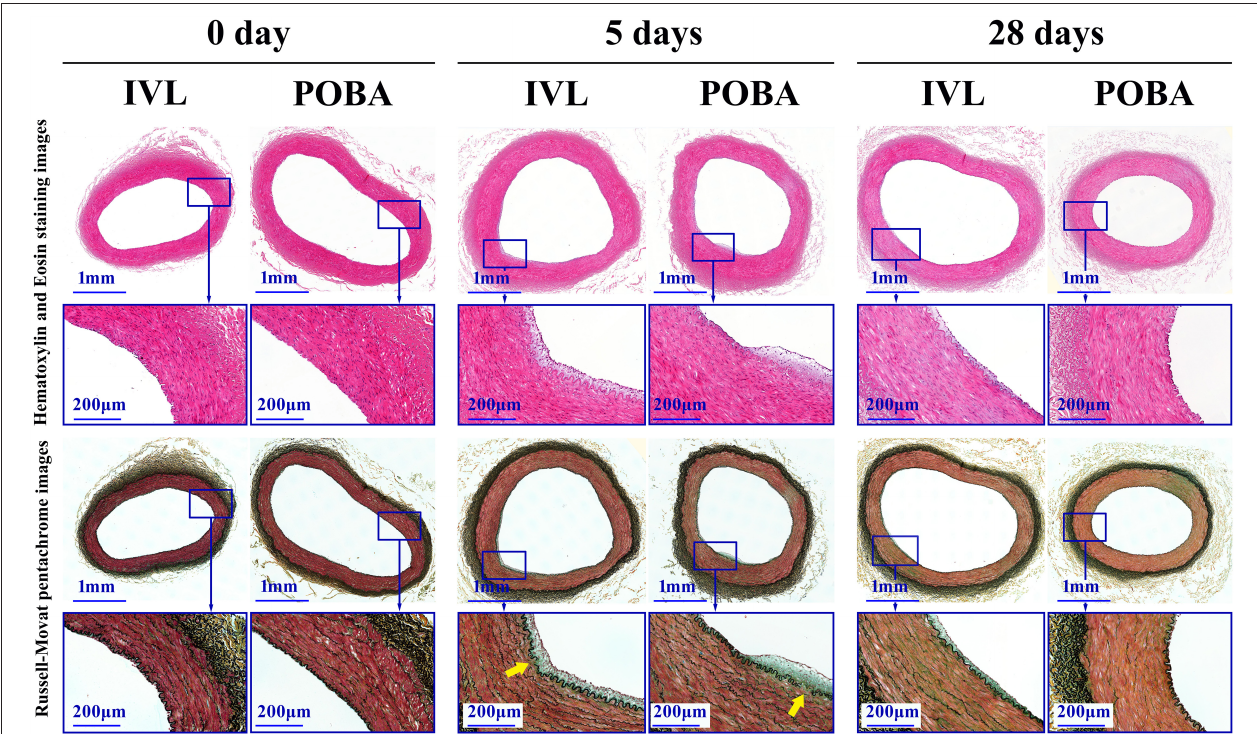
FIGURE 3 | Representative histological images of treated arterial segments at 0, 5, and 28 days postoperatively. Magnified images of rectangular areas are shown below each low-magnification image. Slightly non-uniform neointimal thickening was observed in both groups at 5 and 28 days. Noticeable neointimal thickening was located at sites of internal elastic lamina laceration (yellow arrows). IVL, intravascular lithotripsy; POBA, plain old balloon